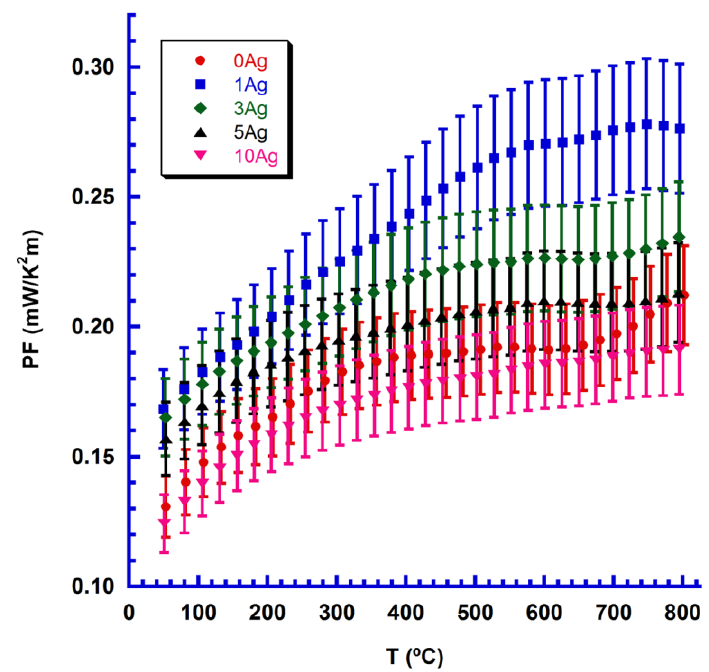
Figure 6. PF change with temperature for Ca 0.9 Yb 0.1 MnO 3 + x wt.% Ag samples (given as a function of Ag content), together with their measurement errors.